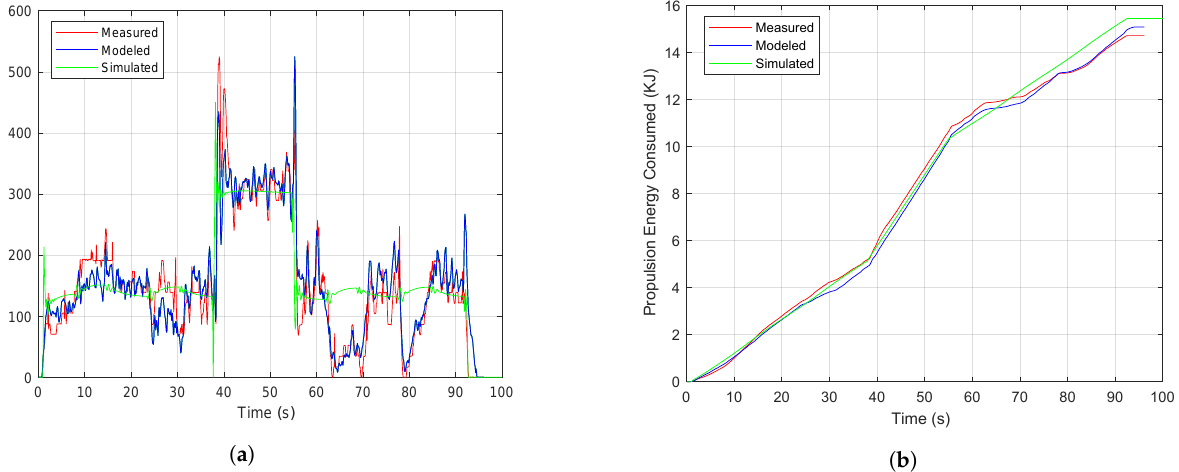
Figure 13. Comparison of ( a ) propulsion power and ( b ) energy consumed from experimental measured (red), experimental modeled (blue), and simulated (green) results using the propulsion power